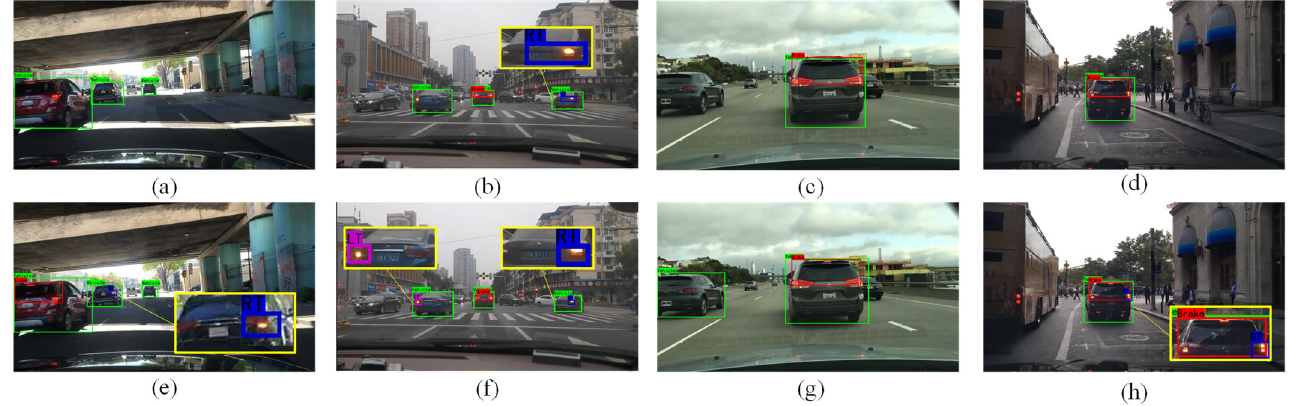
Figure 8. Detection results of the baseline and proposed method on the test set. ( a – d ) the detection results of the four test images in the baseline. ( e – h ) the detection results of the four test images in the proposed method.